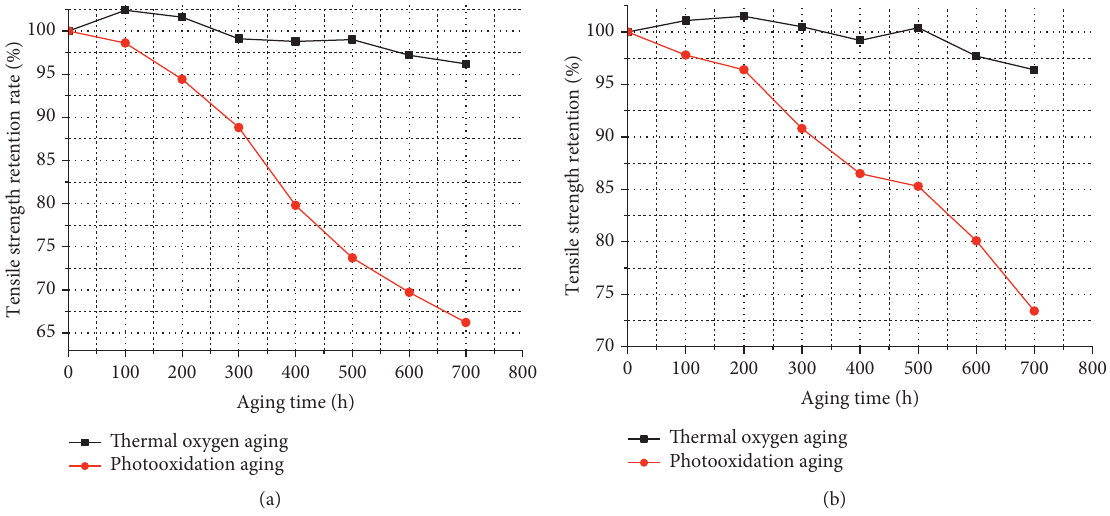
Figure 8: Relationship curves of tensile strength retention rate-aging time. (a) BG1. (b) BG2.